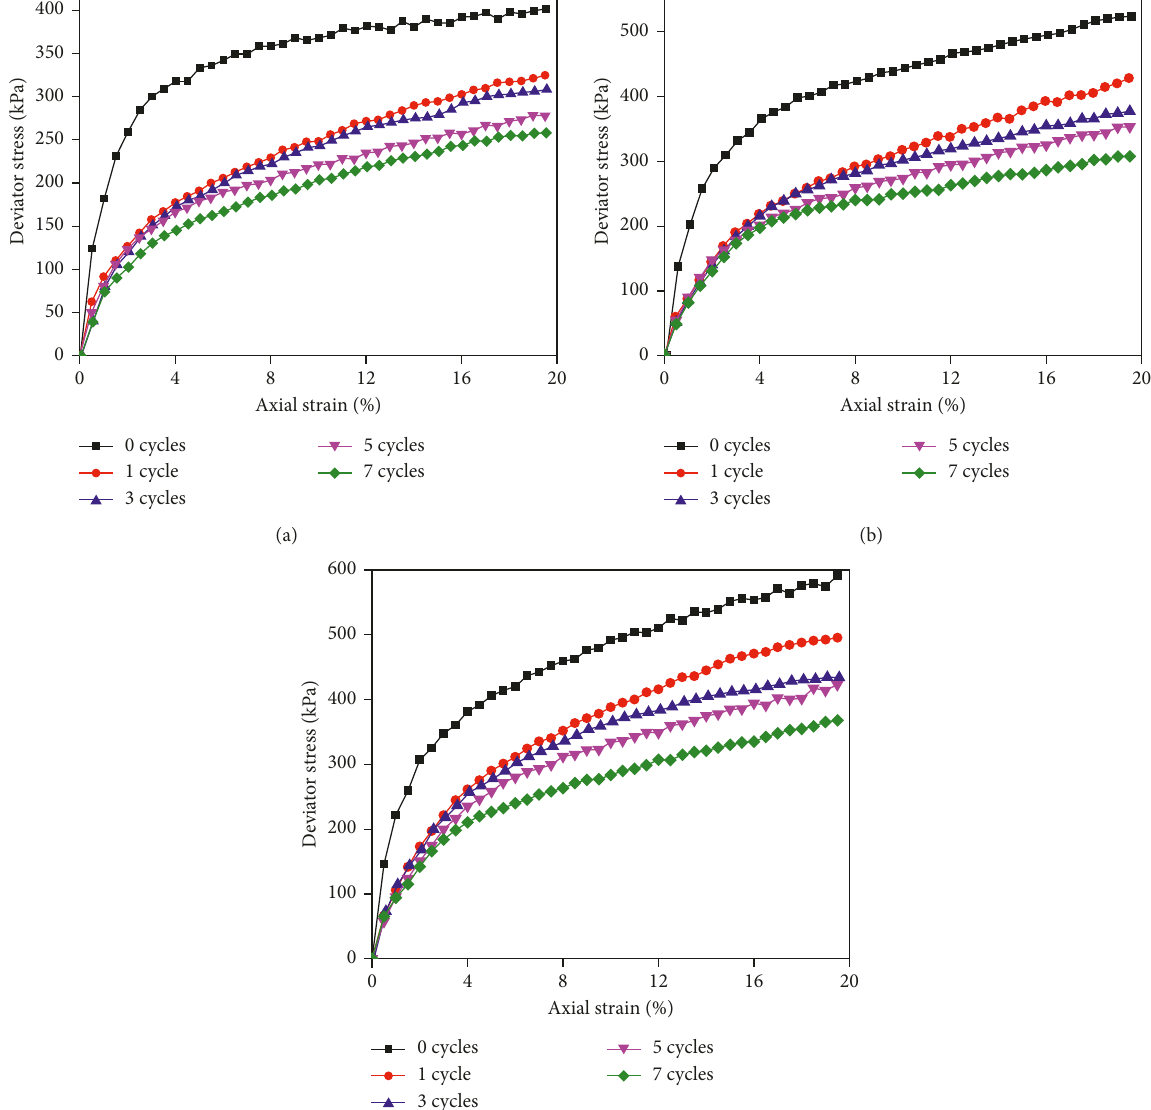
3 (cid:31) 50 kpa. (b) σ 3 (cid:31) 100kpa. (c) σ 3 (cid:31)